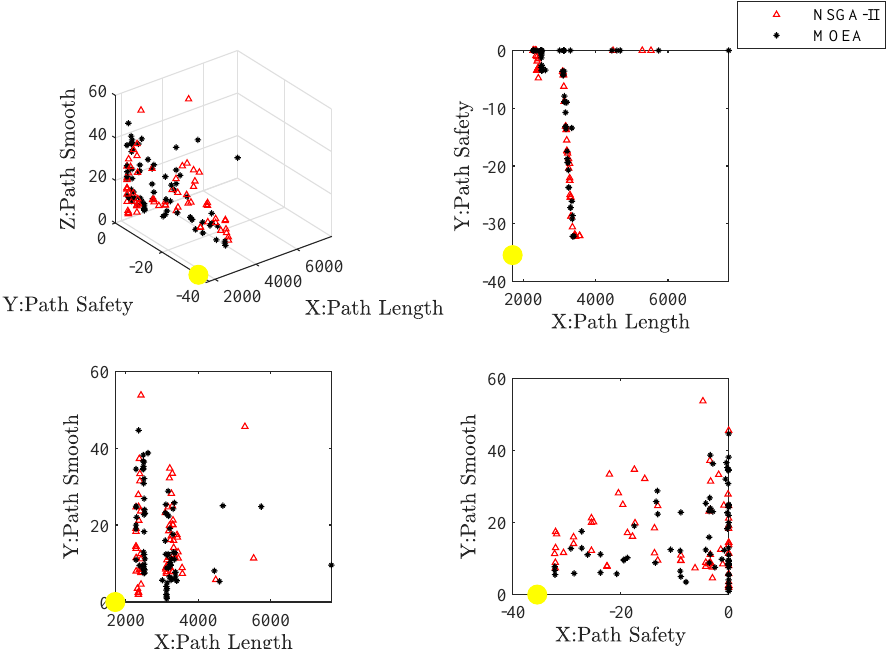
Figure 24. Based on Figure 11B, the approximate Pareto fronts generated by the two algorithms NSGA-II and MOEA. The sub-figure of the upper left corner shows the image of the approximate Pareto front in three-dimensional space. The remaining three sub-figures are the projections of the approximate Pareto front in the two-dimensional